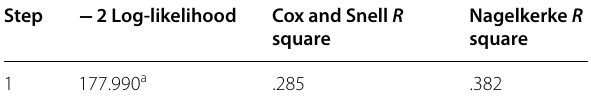
SLE strongly less emphasized; LE less emphasized; NC no change, E emphasized, SE strongly emphasized